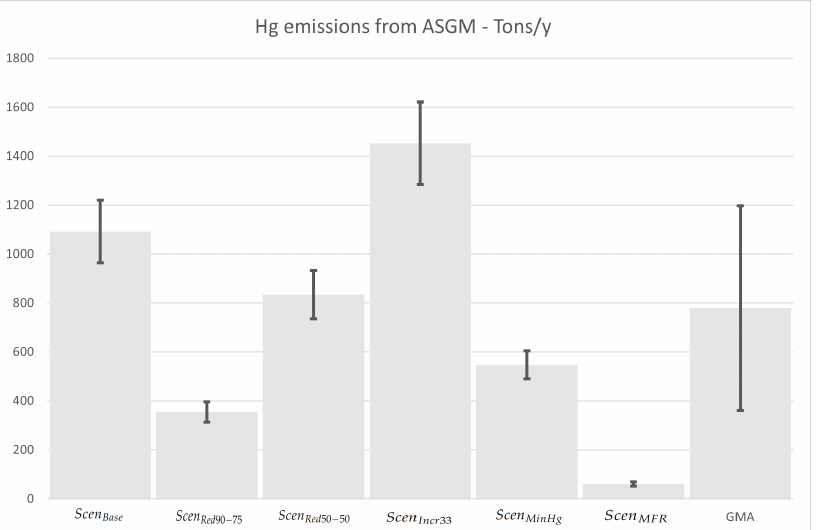
Figure 4. Six emission scenarios of Hg from ASGM compared to GMA. The reduced uncertainty associated to estimates of this study allows for a critical assessment of the scenarios